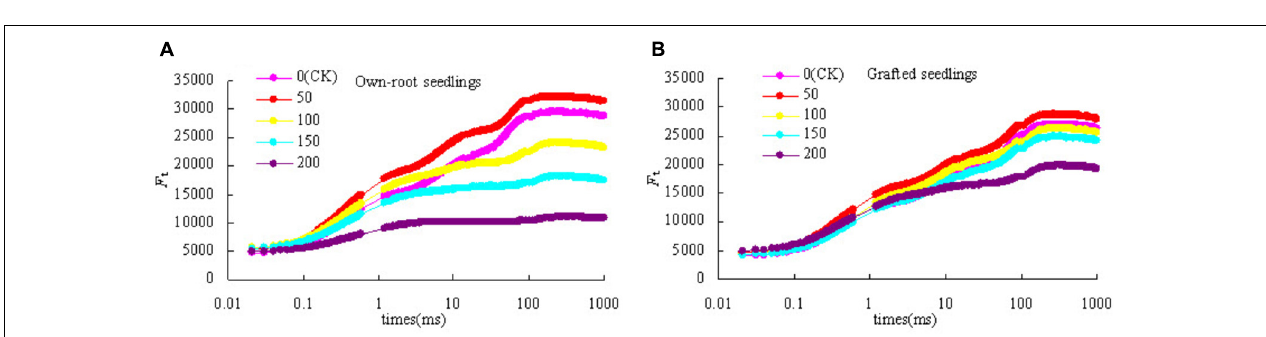
FIGURE 4 | OJIP curve of mulberry own-root seedlings (A) and grafted seedlings (B) under salt stress.